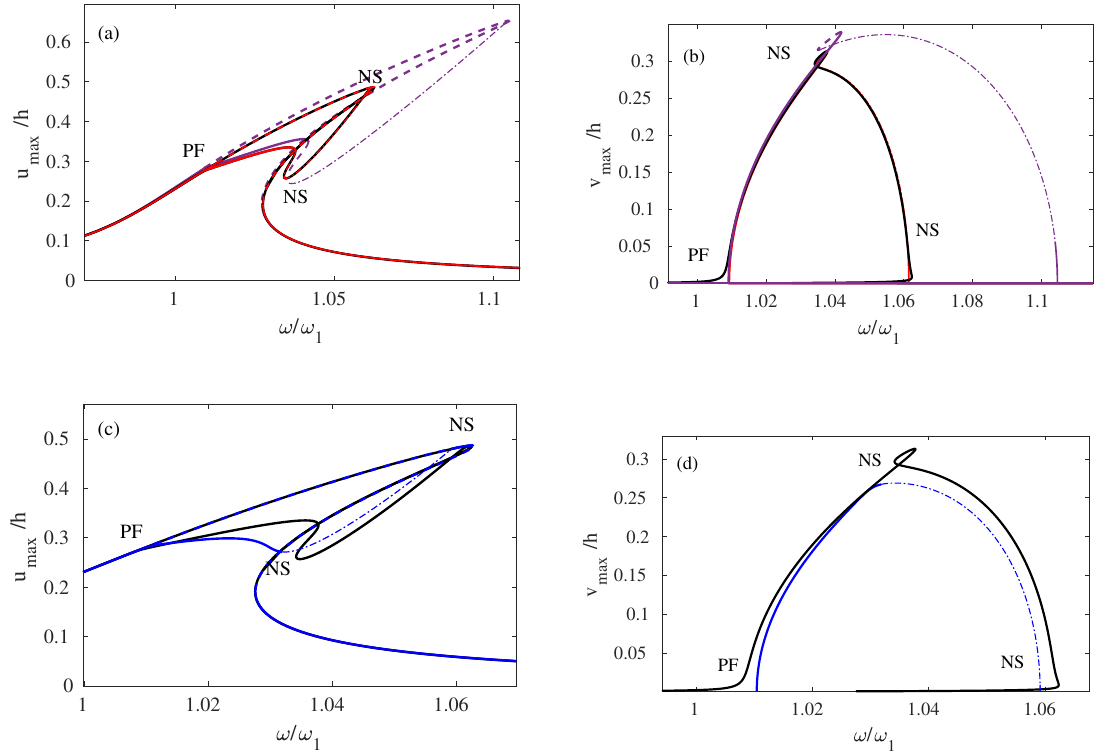
Figure 10. Frequency-response functions for the beam with 1:1 resonance without detuning. The left column is the solution in the u direction (driven mode), and the right column is the solution in the v direction (second polarization, companion mode). The full-order reference solution (black, without stability) is compared to different ROMs. ( a , b ): ICE (purple) and DNF (red) methods. ( c , d ): QM–SMD method (blue). PF: pitchfork bifurcation point. NS: Neimark–Sacker bifurcation. Solid curves: stable part, dashed curve: unstable solution, dash-dotted curve: unstable solution between the NS points (quasi-periodic